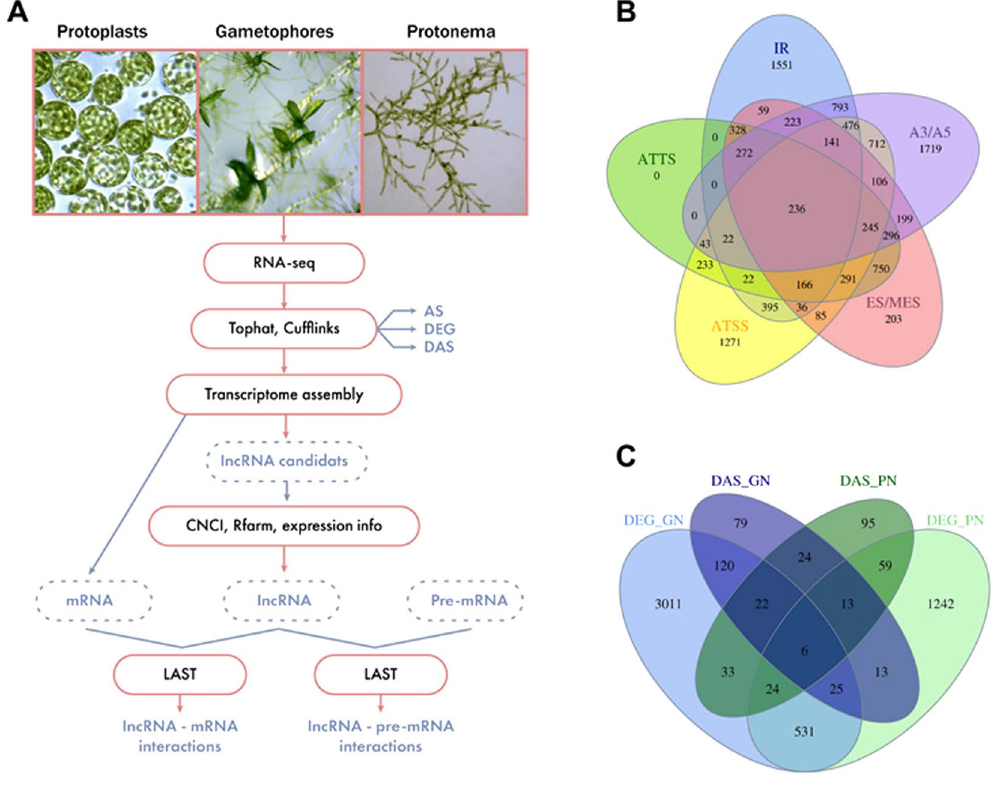
Figure 1. ( A ) The analysis pipeline. Transcriptome profiling data of gametophores, protonameta and protoplasts were analyzed by TopHat and Cufflinks and were searched for differentially expressed (DE) and differentially alternatively spliced (DAS) genes. LncRNAs candidates from transcriptome assembly were filtered by the Coding-Non-Coding Index (CNCI) program and BLASTed against Rfam database. The LAST alignment tool was used to calculate the potential lncRNA-mRNA and lncRNA-pre-mRNA interactions. ( B ) Venn diagram showing the different types of AS events identified in the Physcomitrella paten s. ( C ) Representation of differentially alternatively spliced (DAS) genes compared to differentially expressed (DE) genes in protonemata and protoplasts (DAS_PN and DEG_PN), and protonemata and gametophores (DAS_GN and